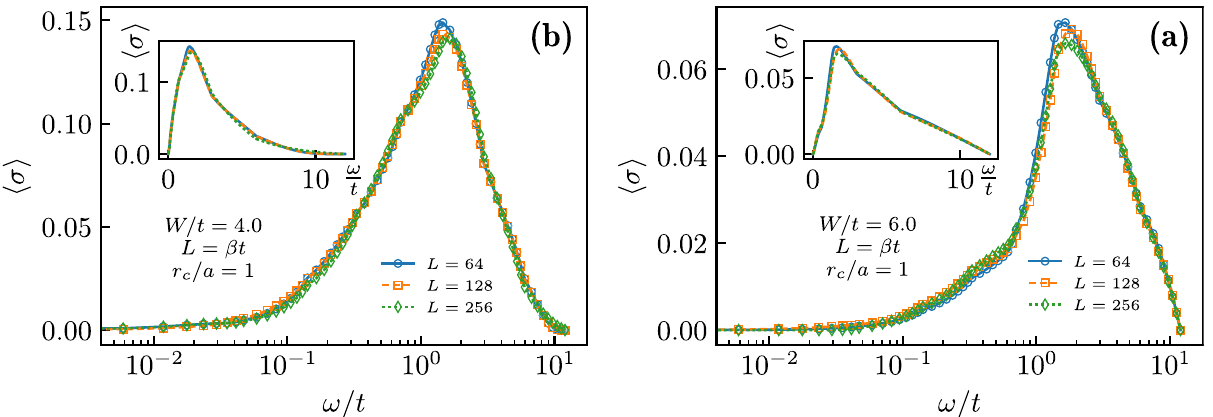
Fig. 7 Optical conductivity for the nearest-neighbor hopping case. Disorder-averaged optical conductivity 〈 σ ( ω ) 〉 as a function of frequency ω for a W = 4 and b W = 6, for a system with nearest-neighbor only hopping. Data were shown for system sizes L = 64 (blue circles), 128 (orange squares), and 256 (green diamonds). Main plots show data on the logarithmic scale for the frequency, highlighting the behavior for small ω . Insets show data on a linear